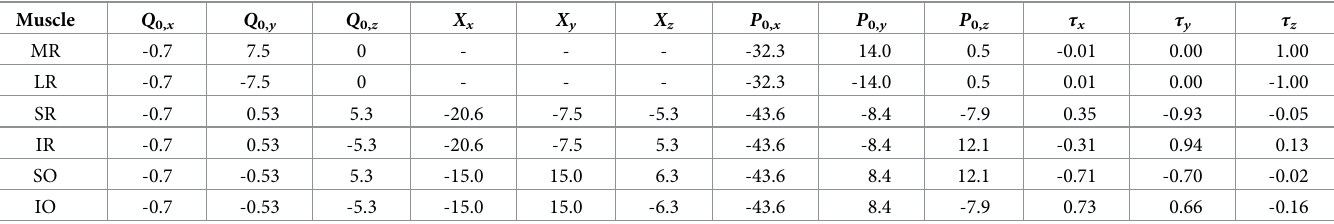
(Table 1), will change as a result of the eye’s rotation (given by the rotation matrix, R ) Table 1. Coordinates of the insertion points (in cm) on the mechanical model of the right eye at rest ( Q 0, i ), and the craniocentric via points (‘pulleys’) ( X i ) with respect to the (head-fixed)center of the eye. Here, LR and MR have no pulleys; they directly connect to driver 2. The cranial insertion points, P i ,0 at rest are given in columns 8–10. Columns 11–13: the unit torque-vector components, as computed from Eq (18) with the eye in the resting orientation. Note that the SO, IO, SR and IR ten- dons all pull with a prominent cyclo-torsional ( x ) and vertical ( y )